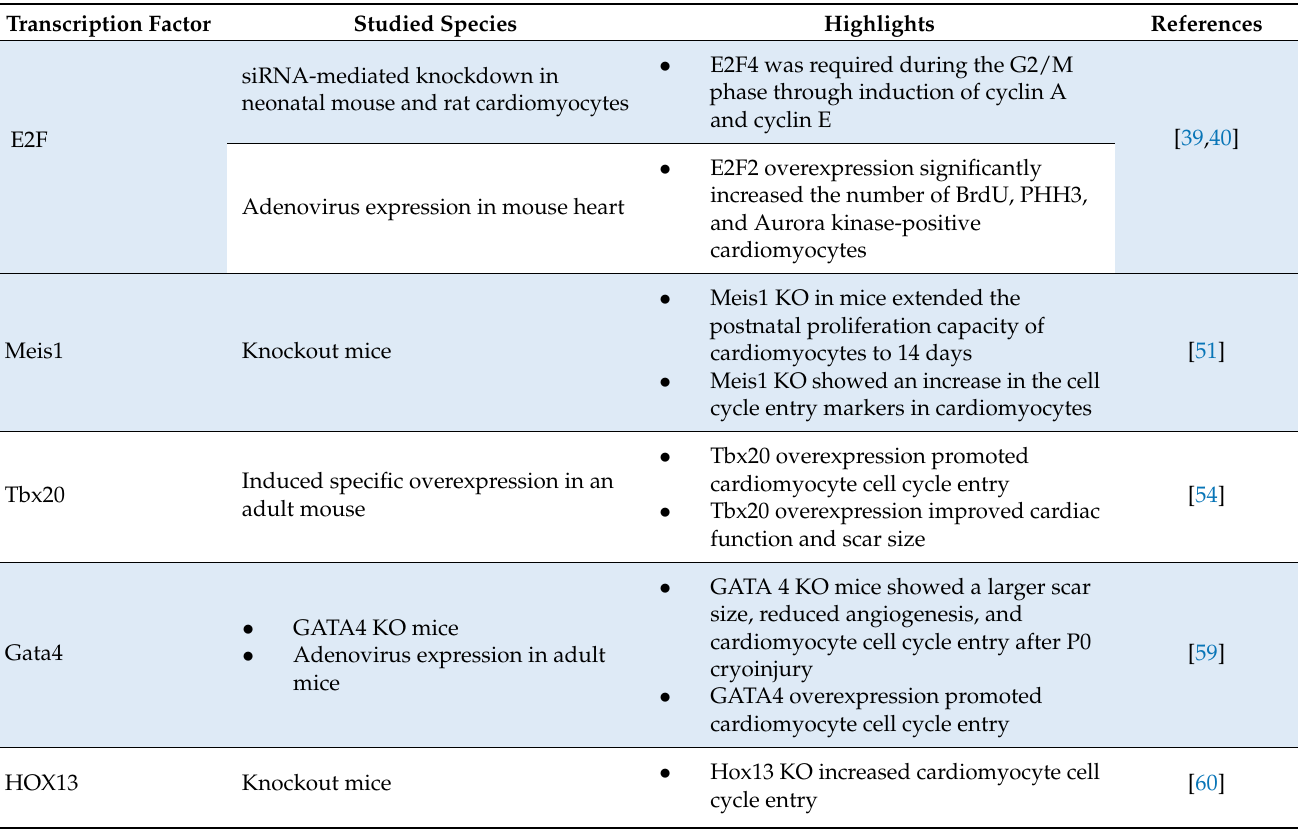
Table 2. Transcription factors that regulate cardiomyocyte cell cycle